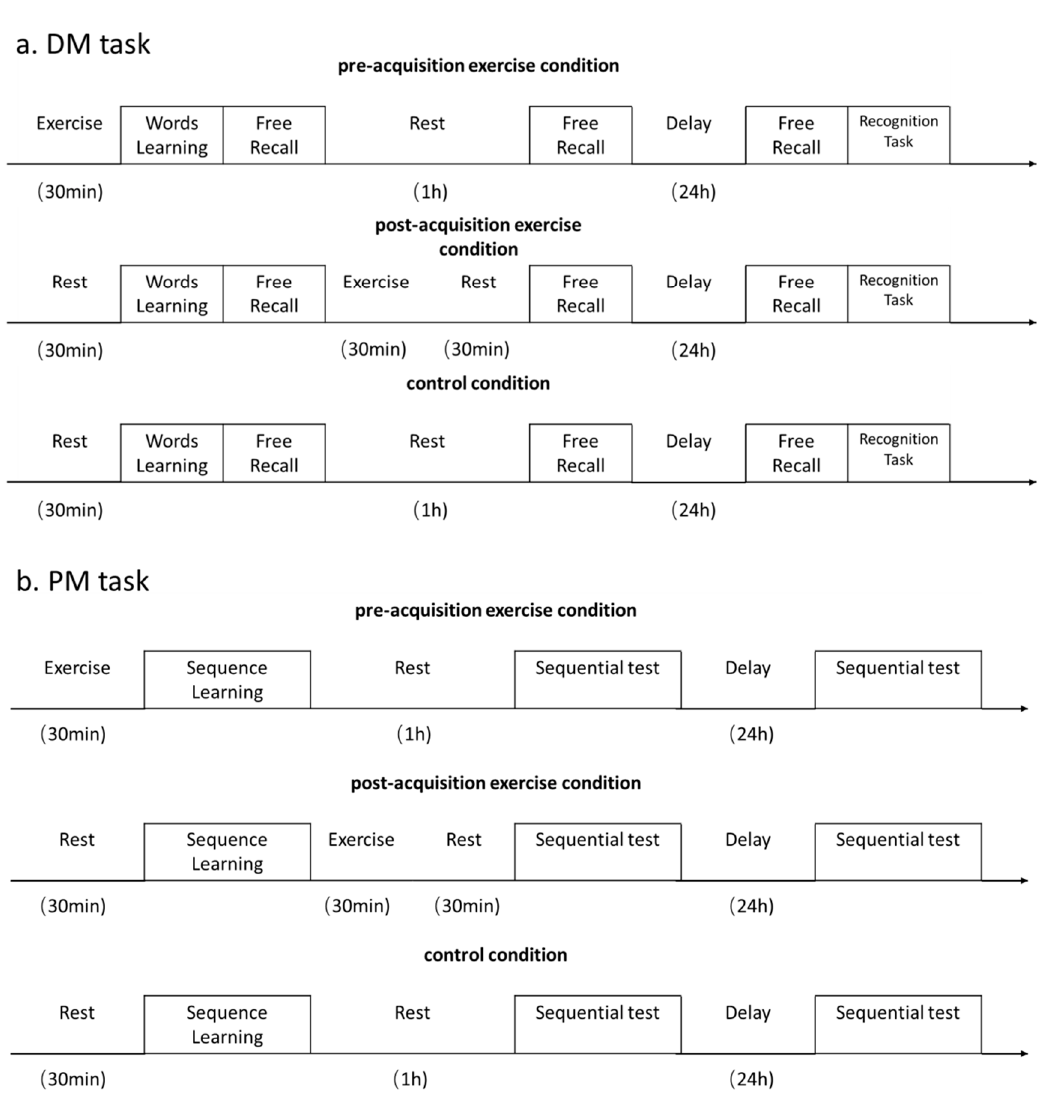
Figure 2. Task flow and experimental conditions for the declarative memory (DM) ( a ) and procedural memory (PM) ( b ) tasks.